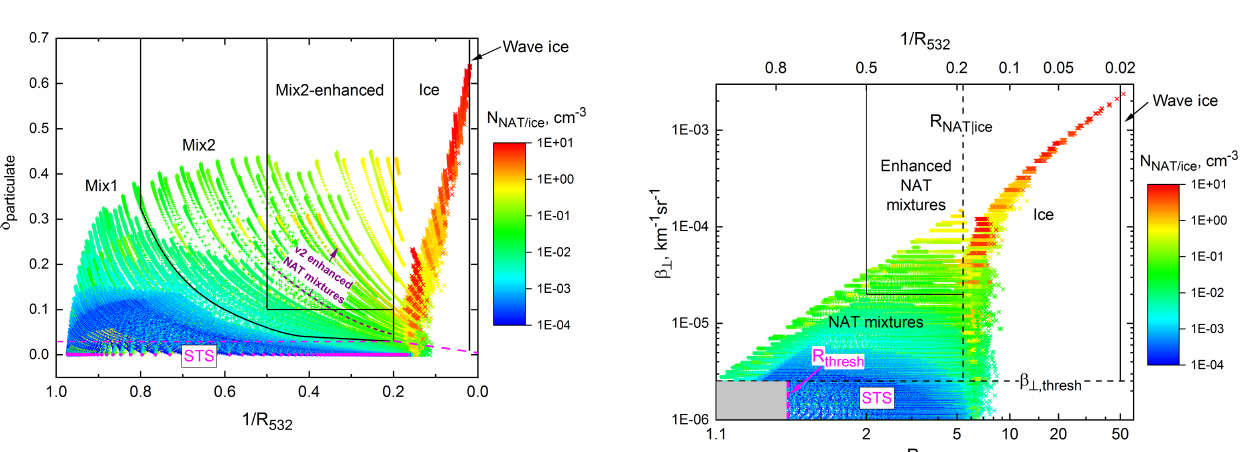
Figure 3. Theoretical optical calculations for non-equilibrium liquid–NAT and liquid–ice mixtures, illustrating the v1 PSC com- position classification scheme. The dashed purple curve represents the lower boundary of the v2 enhanced NAT mixtures composition class, as discussed in the text and in Fig. 4.